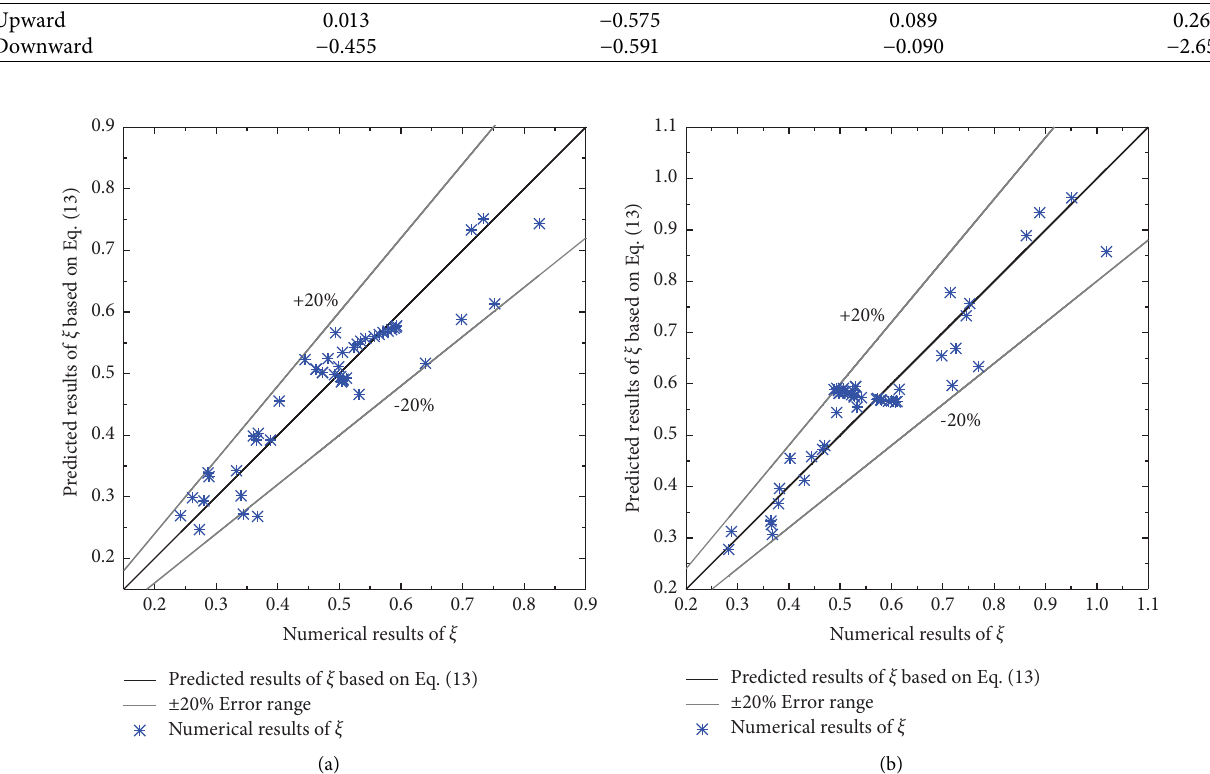
Figure 15: Comparison of predicted and numerical results of ξ in vertical Z-shaped pipes. (a) Upward fow and (b) downward fow.